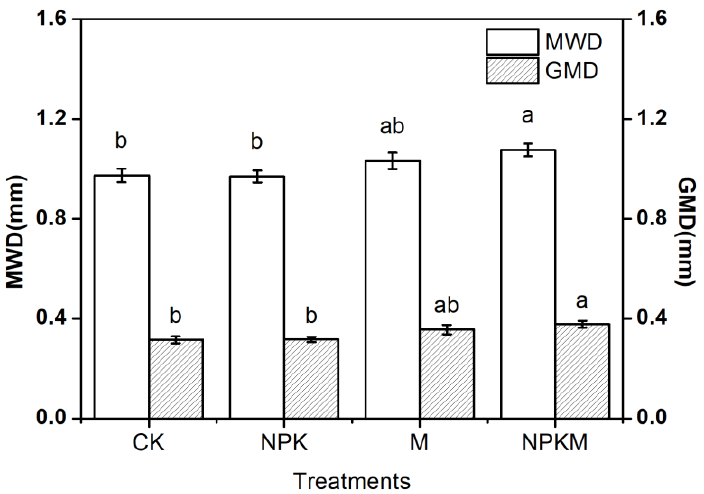
Figure 1. Soil mean equivalent diameter (MWD) and geometric mean diameter (GMD) under different fertilization treatments. Means with similar lowercase letters indicate that values in different treatments were not significantly different at p < 0.05.